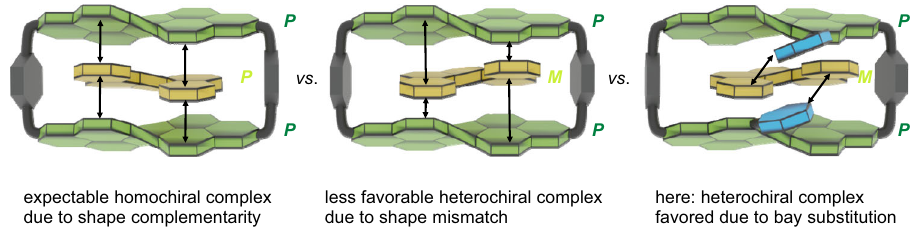
Fig. 6 | Encapsulation of heterochiral guests by PBI cyclophanes. Schematic representation of the expected energetically preferred homochiral complex and the less favourableheterochiralcomplex in the absenceofbaysubstituents